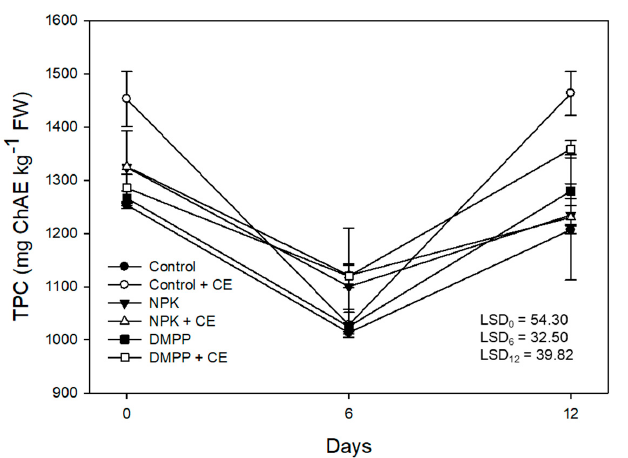
Figure 2. Total phenolic content of fresh spinach leaves at 0, 6, and 12 days of storage at 4 °C. Control; Control + CE, control with compost extract; NPK, inorganic NPK fertilizer 15-15-15; NPK + CE, inorganic NPK with compost extract; DMPP, ENTEC Nitrofoska ® plus the nitrification inhibitor (IN) 3,4-dimethylpyrazole phosphate (DMPP); DMPP + CE, the nitrification inhibitor (IN) with compost extract.